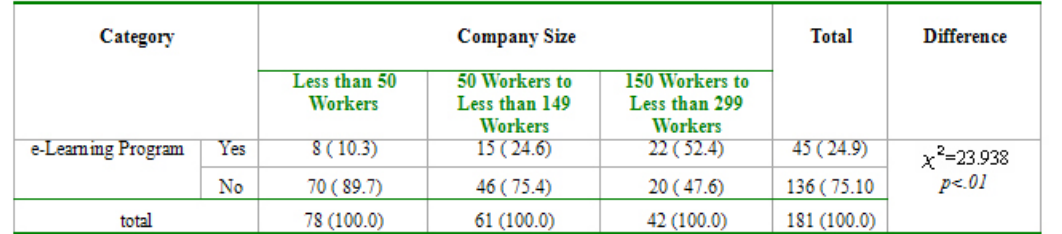
Table 4. e-Learning Program Proportion Change by Company Size in